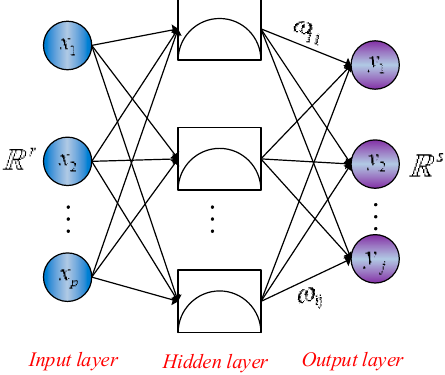
Figure 1. The architecture of RBF neural network.